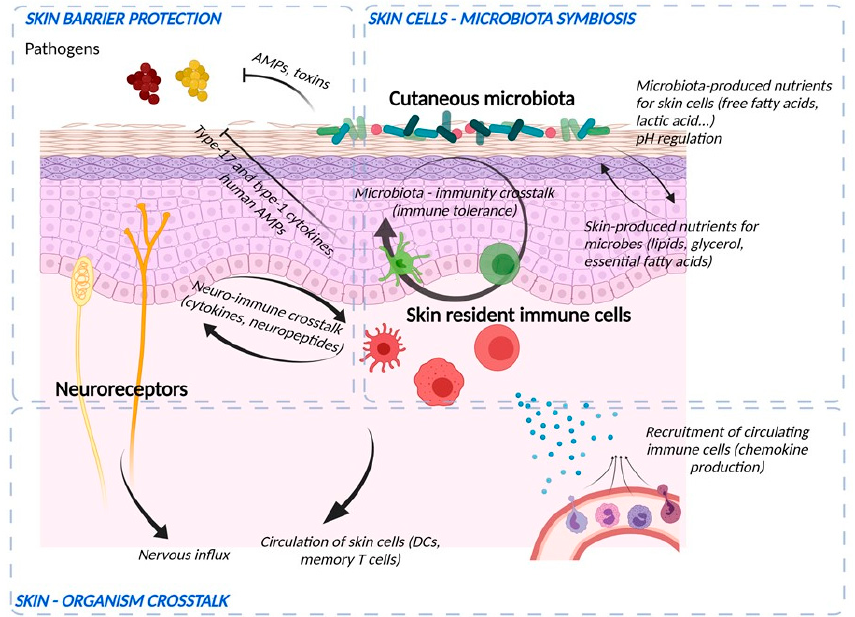
Figure 4. Crosstalk between microbiological, immunological, and sensory nerve barriers of the epidermis. Bacteria and skin cells are organized in a symbiosis in which nutrients are shared and protection from environmental hazards (e.g., pathogens) is provided by the different actors. Bacteria produce their own AMPs and stimulate immune cells and keratinocytes to induce immune vigilance and modulate the epidermal structure. In return, the epidermis produces nutrients and ligands essential for the establishment of commensal flora and develops an anti-pathogen defense via the production of AMPs, the action of cells such as neutrophils and macrophages, the production of cytokines to potentiate the action of these cells and chemokines to recruit them from the bloodstream. Immune cells and keratinocytes also interact with nerve endings (“neuroinflammation”) to potentiate the response to pathogens and participate in sensory awareness. Finally, the skin barrier informs the body by sending nerve impulses and circulating skin cells to lymphoid organs.